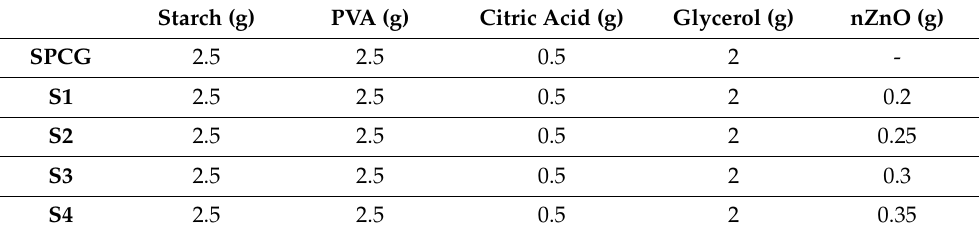
Table 1. Starch-based-material